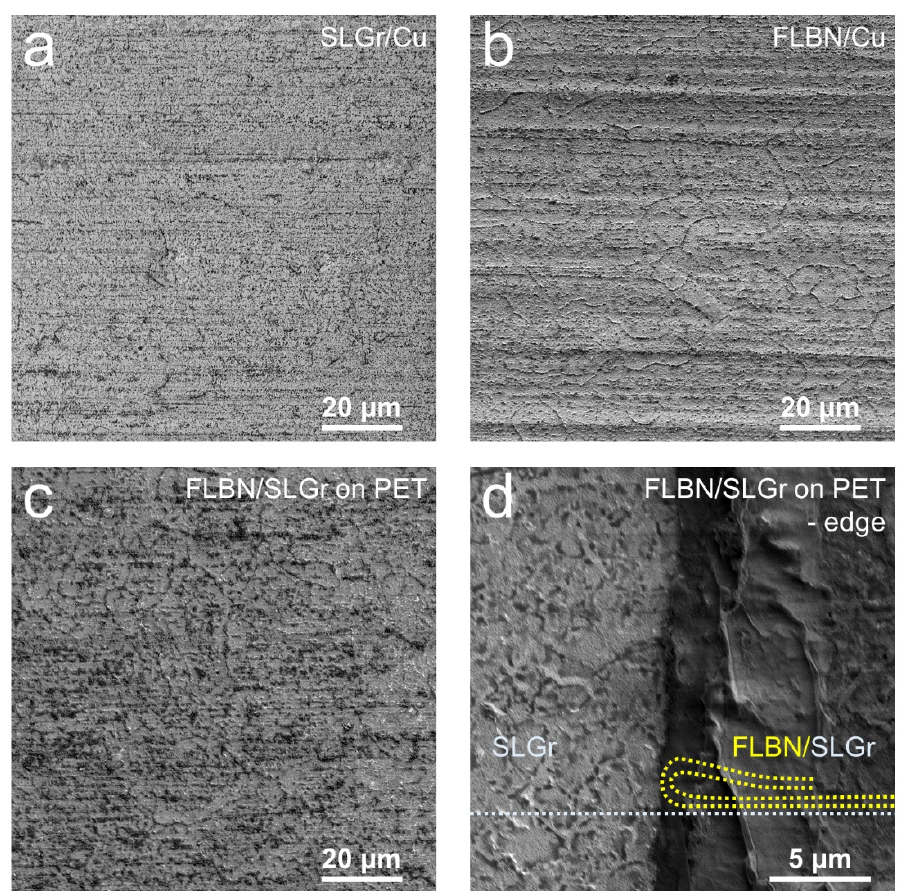
Figure 3. Surface characterization of as-grown SLGr, FLBN, and the prepared heterostructures. SEM images depict ( a ) SLGr and ( b ) FLBN grown on Cu foil. The SEM image in ( c ) shows large area surface morphology at the center part of the heterostructure stuck transferred onto PET substrate, while the image in ( d ) depicts a zoomed-in image of the edge area of the same FLBN/SLG heterostructure sample after applying the wet transfer procedure on Au-coated PET substrate.